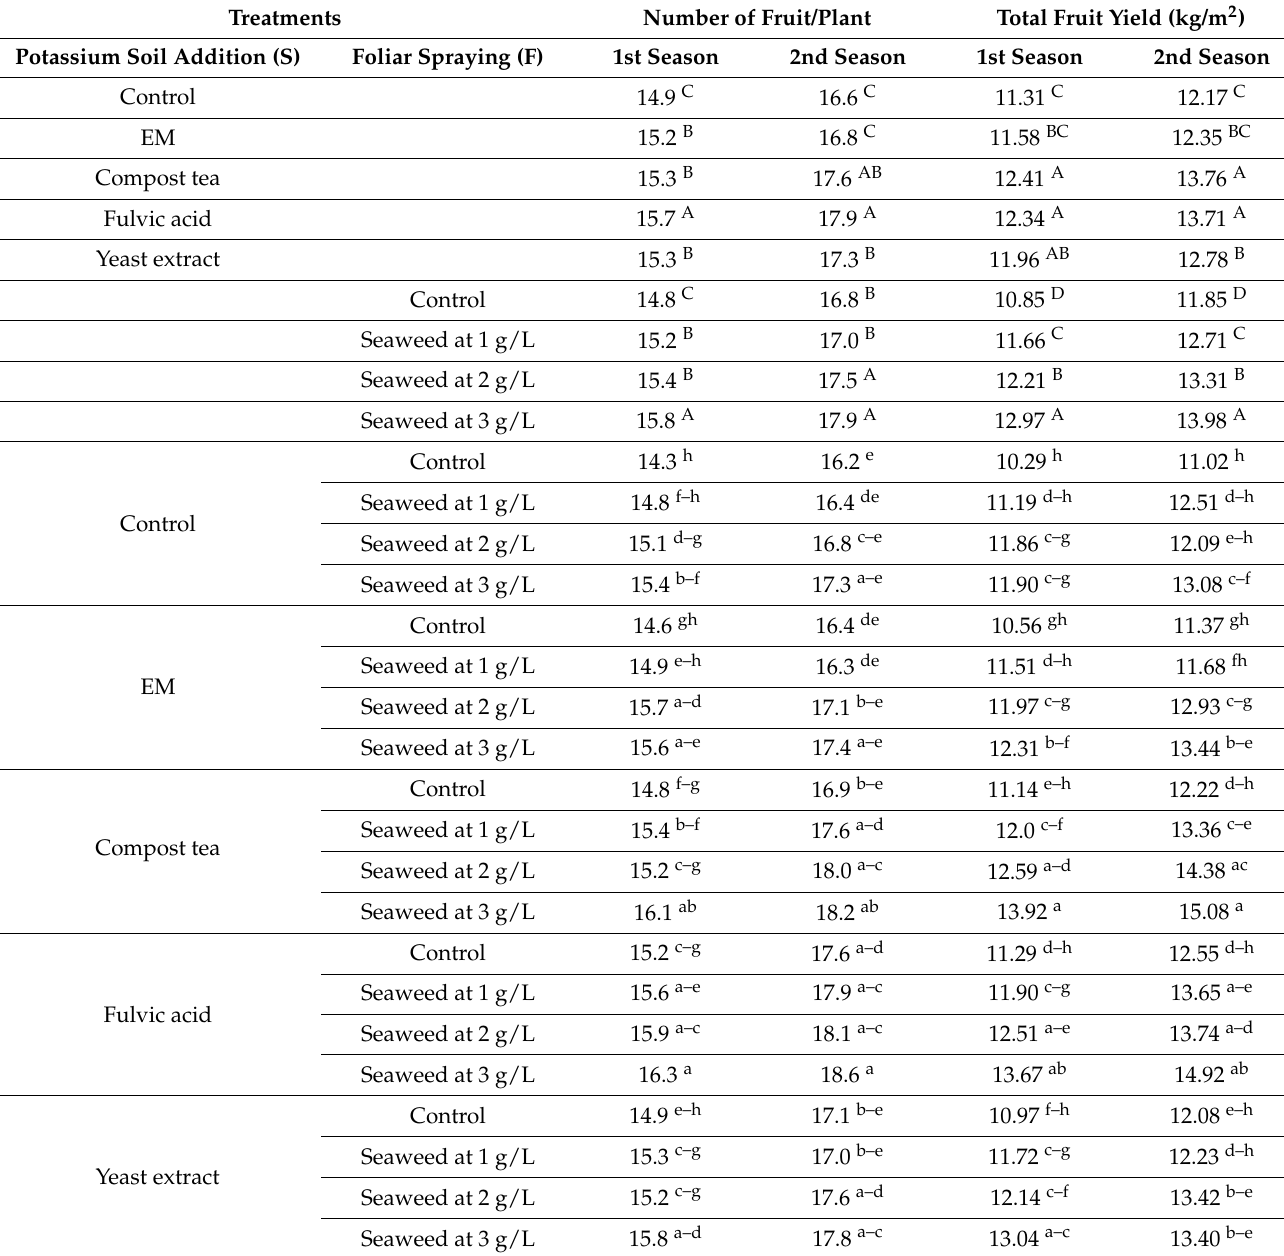
Table 4. Effects of soil addition of EM, compost tea, fulvic acid, yeast extract, and foliar spray with seaweed extract and their combination on fruit yield of sweet pepper plants during the 2019/2020 and 2020/2021